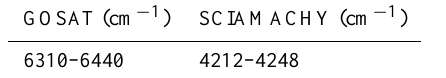
Table 1. Retrieval windows for HDO and H 2 O used for GOSAT and SCIAMACHY.